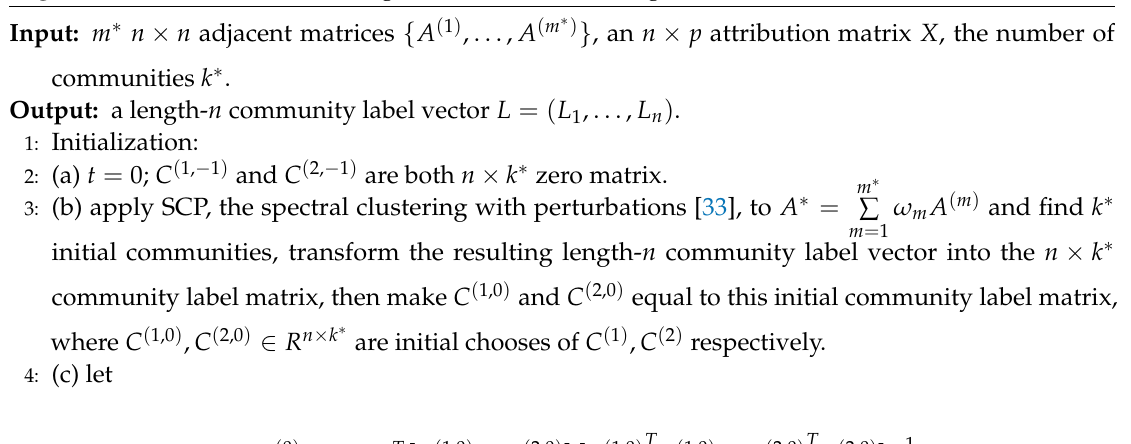
Algorithm 1 Penalized Alternating Factorization (PAF)